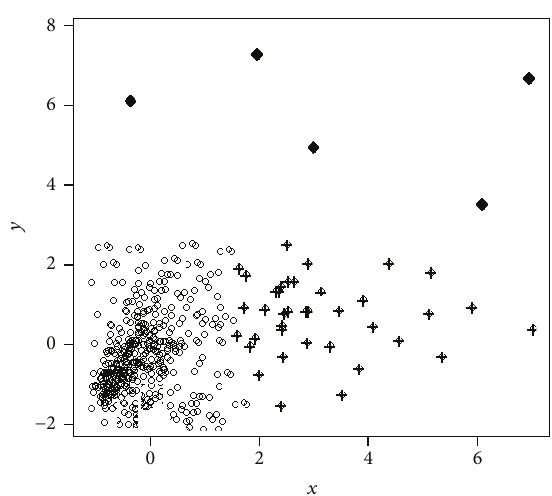
Figure 4: Outliers clearly distancing from the other objects — the result obtained by k -NN k = 5 .